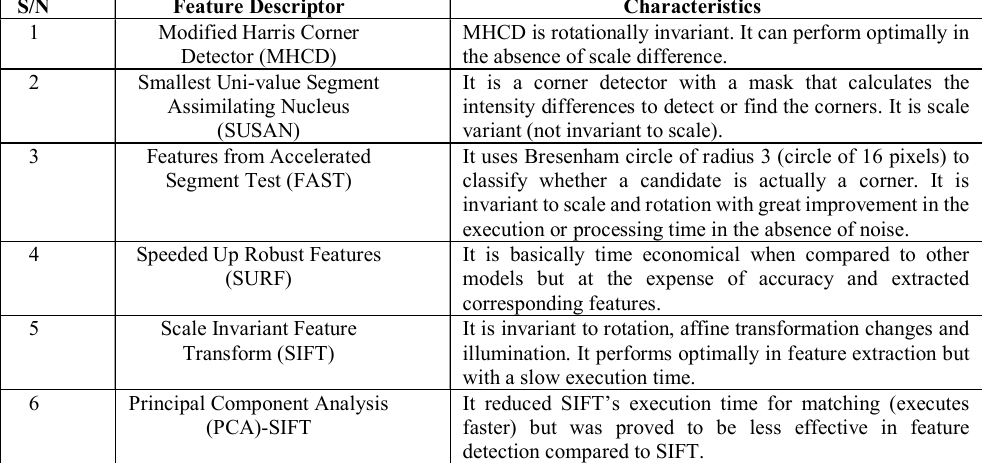
Table 1: Major characteristics of some of the widely-used feature detection and extraction algorithms S/N Feature Descriptor Characteristics Modified Harris Corner Detector (MHCD)